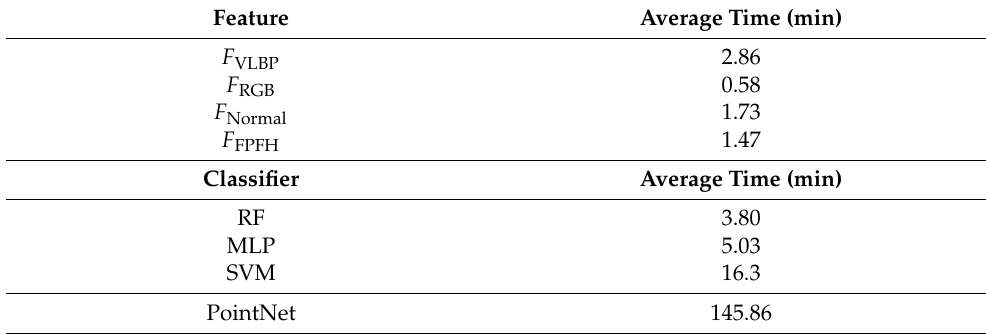
Table 4. Statistics of average running time under the condition of different features and classifiers.